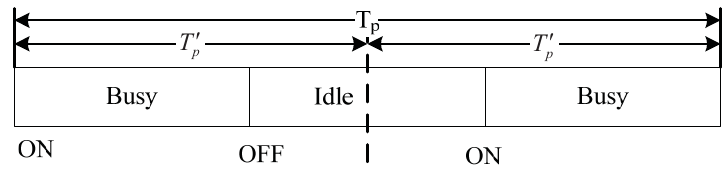
Figure 5. Sensing period including two state